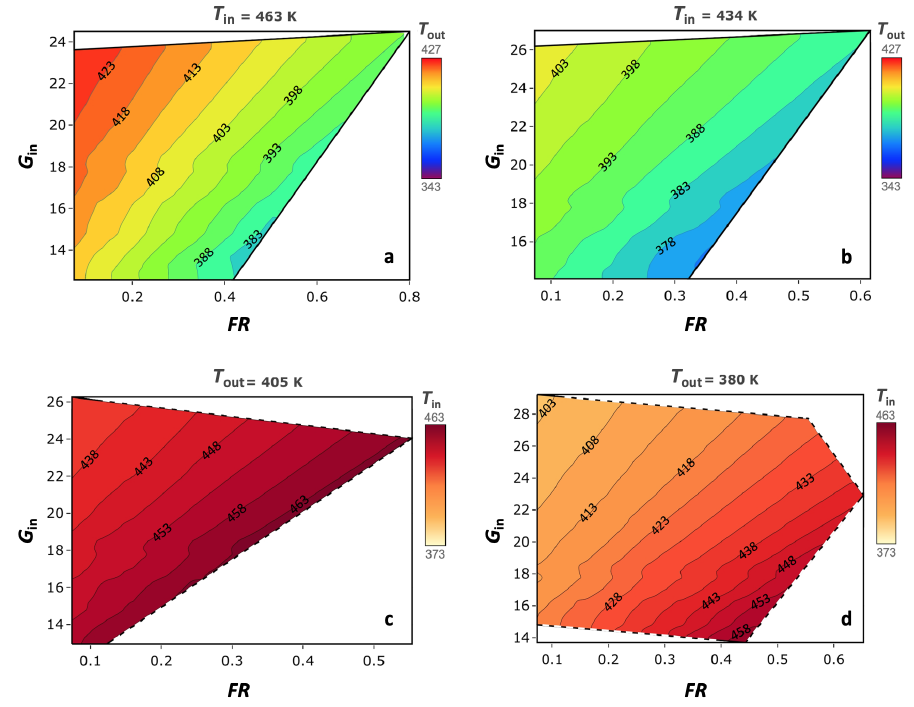
Figure 9. Contour plots of DS volume sections at two different T in , 463 and 434 K ( a , b ), and two T out , 405 and 380 K ( c , d